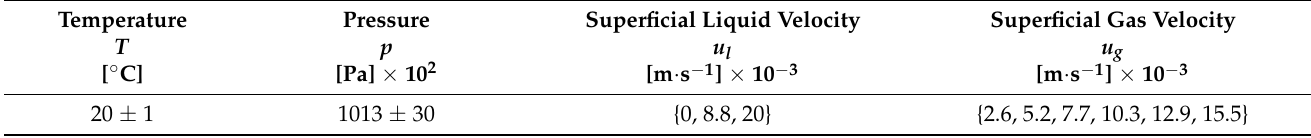
Table 1. Experimental